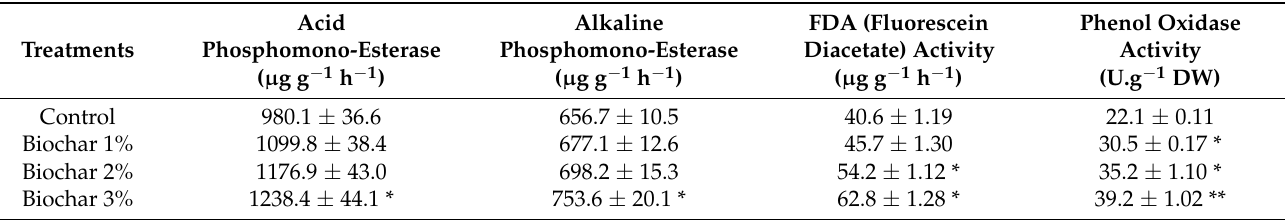
Table 4. The impact of biochar concentrations on soil